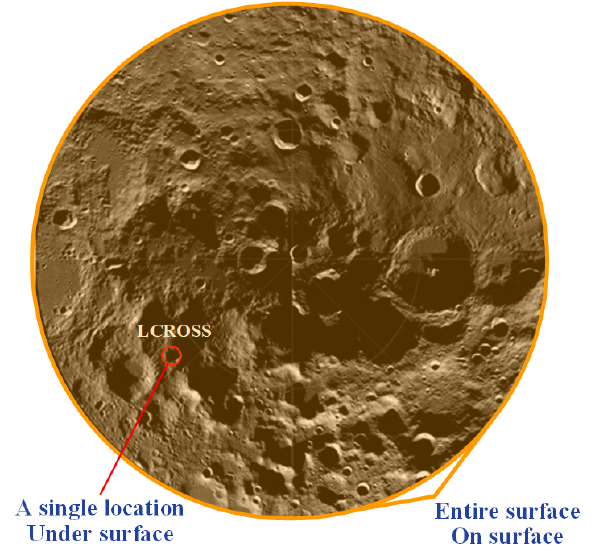
Figure 13. South polar regions of the Moon. The LCROSS [5] impact region is shown by a red